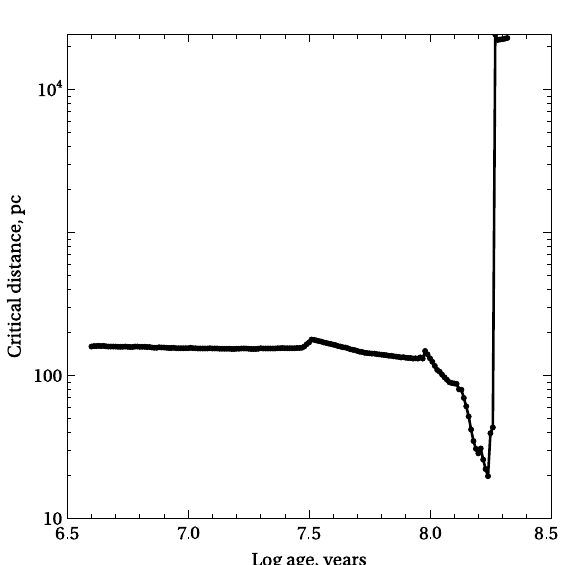
Fig. 5. Critical distance of binary detection as a function of age for the system with a 4 M ⊙ primary and a 3 M ⊙